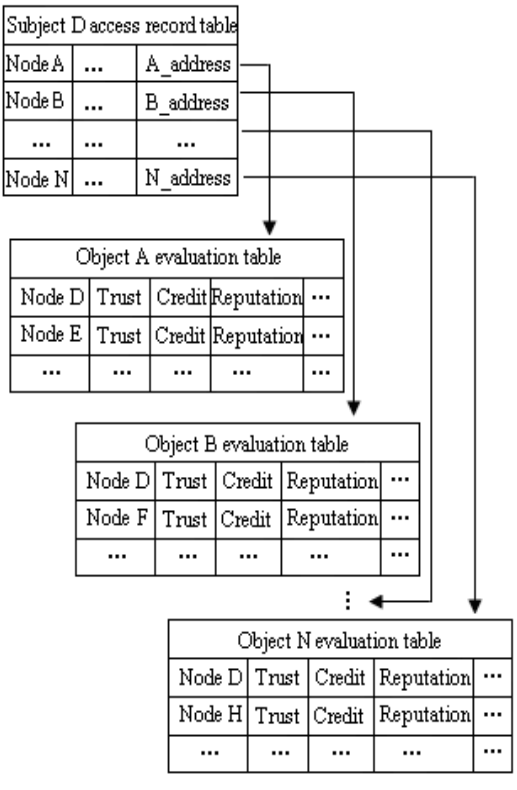
Fig. 3. Relationship between a subject’s access record table and objects’ evaluation tables